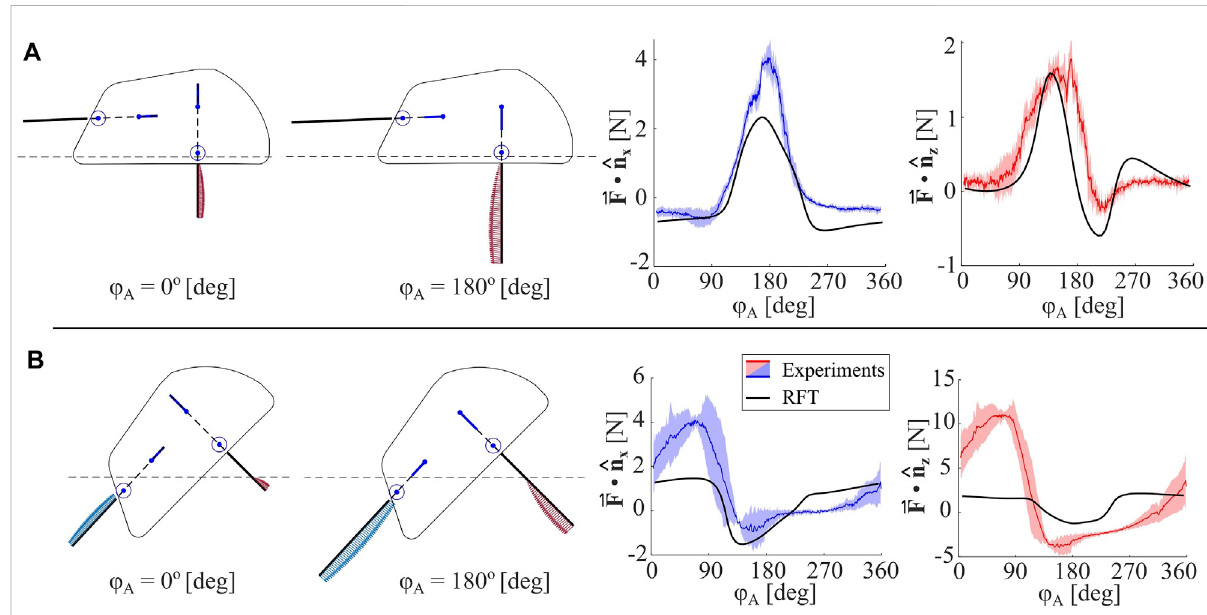
FIGURE 8 AnisotropicLegAnalysis. (A) Measuredhorizontalandverticalforcesforasinglelegpair(meanisdenotedwithacoloredlineandshadedregion indicates standard deviation), and RFT model-predicted forces for an identical body pitch ( θ =0 ° ), depth ( z B 1 = − 0.35 cm ), and phase ( ϕ P − ϕ A =0). Two robot con fi gurations, ie. two values for ϕ A , are shown, and location of granular media surface is indicated with a dashed line (B) Measured horizontal andverticalforcesfortwolegpairs,andRFTmodel-predictedforcesforanidenticalbodypitch( θ =45 ° ),depth( z B 1 =1.27),andphase( ϕ P − ϕ A